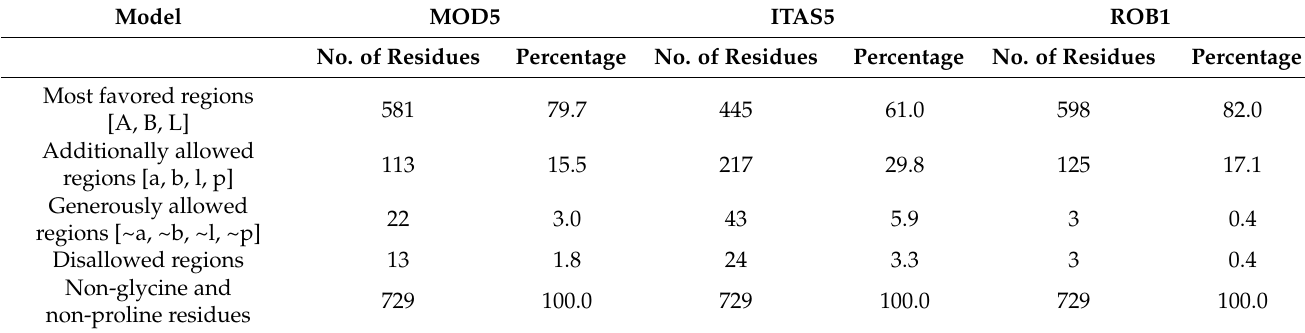
Table 6. Ramachandran plot statistics for the best models from the 3 modelling techniques. For all 3 models, the number of end residues (excluding Gly and Pro) = 2, Glycine residues = 65, Proline residues = 85, and the total number of residues =